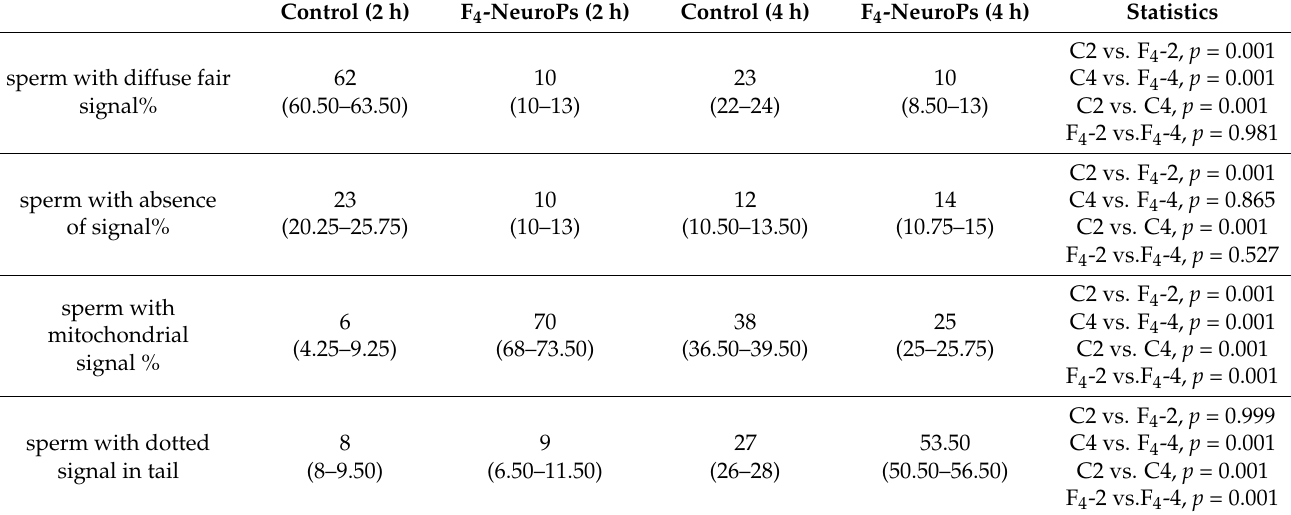
Table 4. Median (IQR) percentage of swim-up selected sperm treated with anti-ryanodine antibody after incubation with 7 ng F 4 -NeuroPs or without F 4 -NeuroPs (control) for 2 and 4 h. Statistics are also reported; p < 0.05 is considered